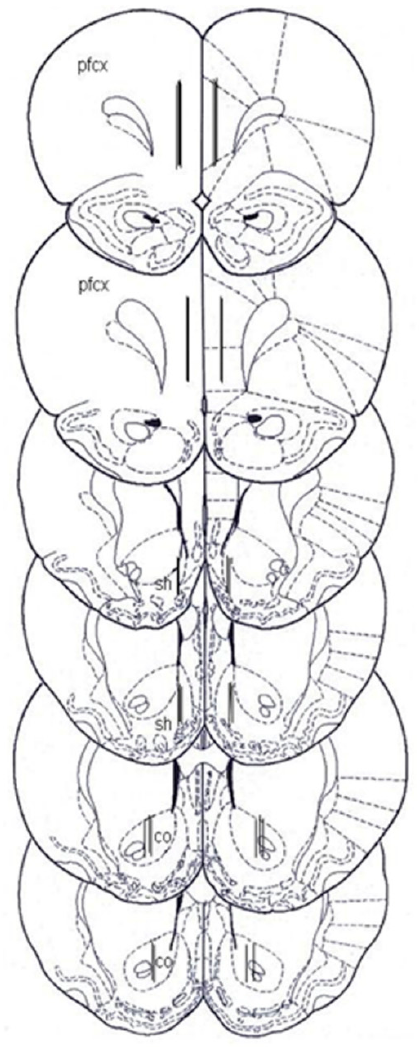
Figure 8. Localization of dialysis probes. Dialysis portions within the mPFCX, NAc shell and core (Adapted from the ref. [87]). pfcx, medial prefrontal cortex; sh, shell; co, core.